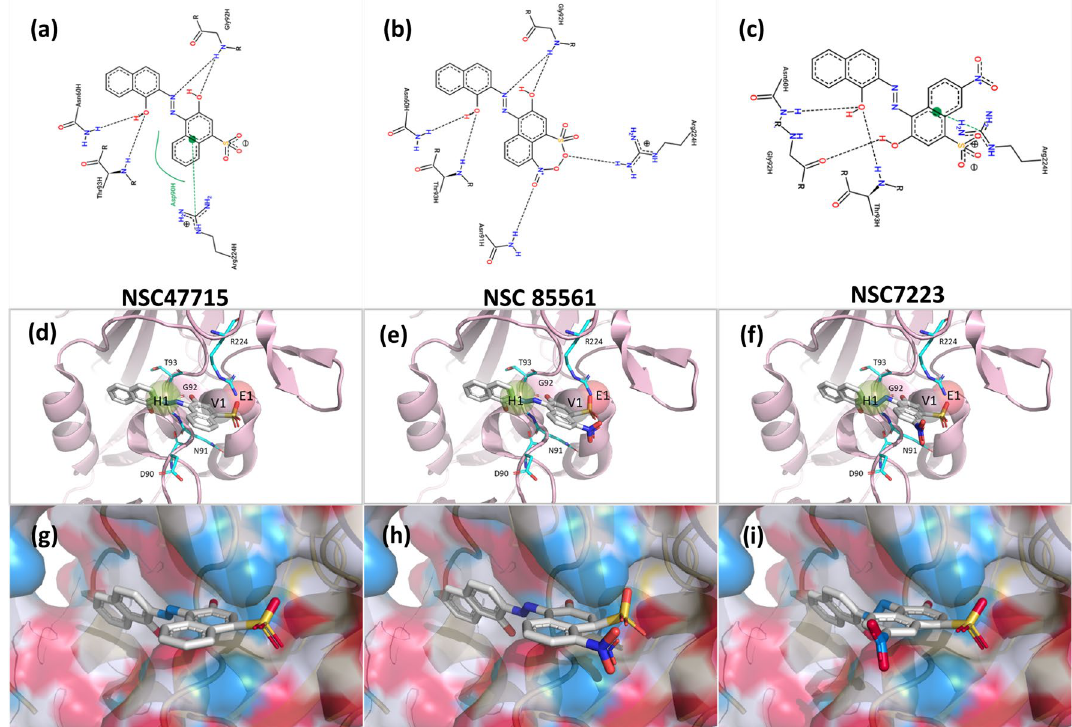
Figure 7. Docked compounds show a high affinity towards the RBS of the HA. The docked compounds (a,d,g) NSC47715, (b,e,h) NSC85561, and (c,f,i) NSC7223 are displayed in different visualization modes. (a–c) The interaction diagrams between docked compounds and proteins are shown in a 2-D plot that were examined by the PROTEINS PLUS server 45 . (d–f) Visualization of the docked compounds with anchors in the RBS. The HA structure is shown in the cartoon, anchors are shown as transparent spheres, interactive residues are shown as cyan sticks, and the docked compounds are shown as grey sticks. (g–i) The docked compounds in the RBS are represented in surface mode. PyMOL software was used to draw all of the 3-D figures 55